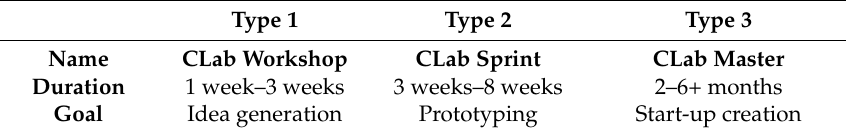
Table 6. Scheme of the type 1, 2 and 3 courses revised in the